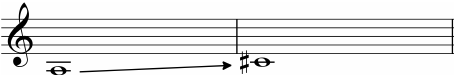
Figure 26. Adding four semitones to pitch A 3 results in C (cid:93)